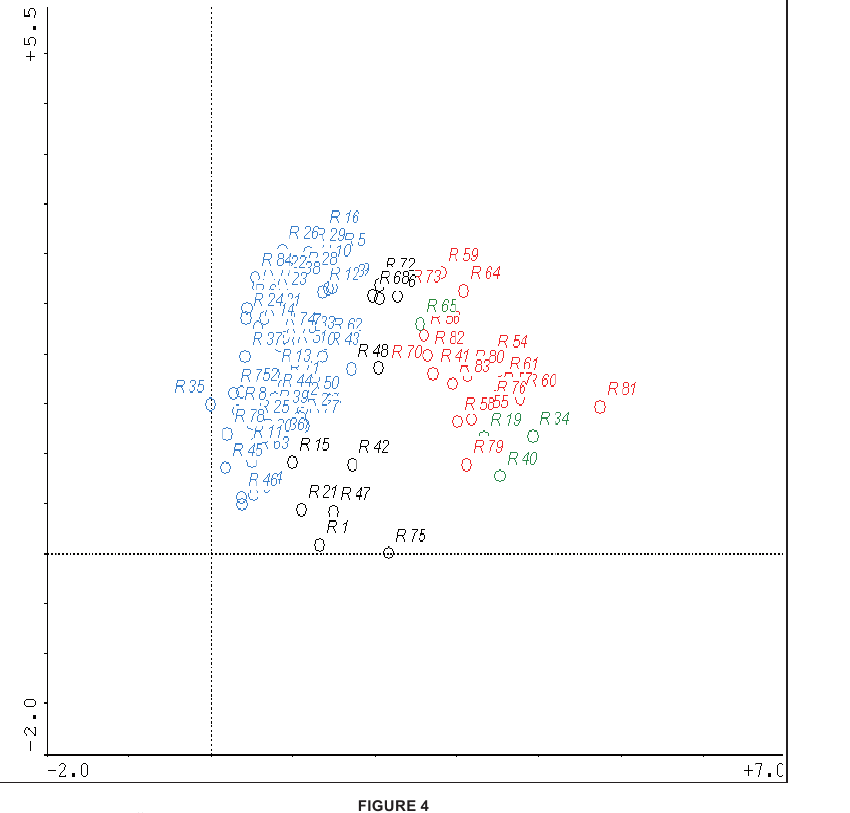
Figure 4 Detrended Correspondence Analysis (ter Braak & Šmilauer 1998) ordination of the data set of the Andover Game Reserve with a SD of 4.75 depicting the terrestrial communities (i.e. relevés representing Community 3 removed). Relevés highlighted in blue and red represent Communities 1 and 2. Relevés highlighted in black and green represent Variant 2a and outliers,